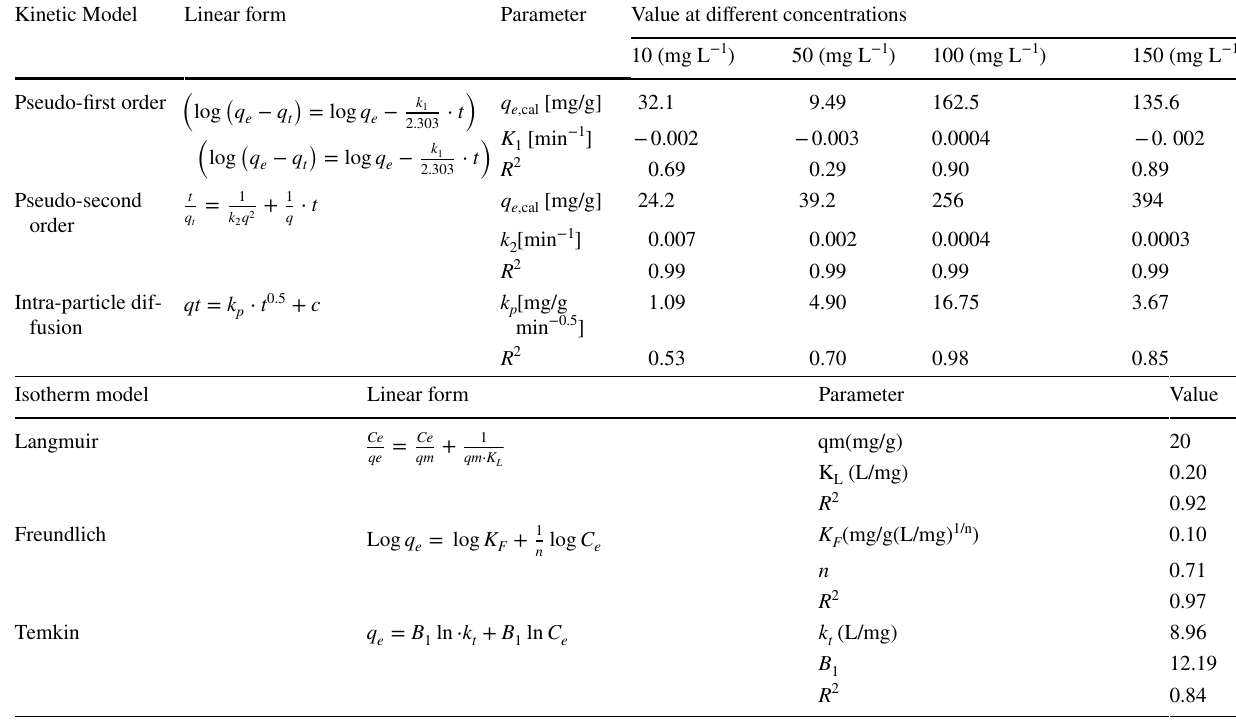
Table 7 The kinetic and isotherm parameters fitted for MNZ removal by S.